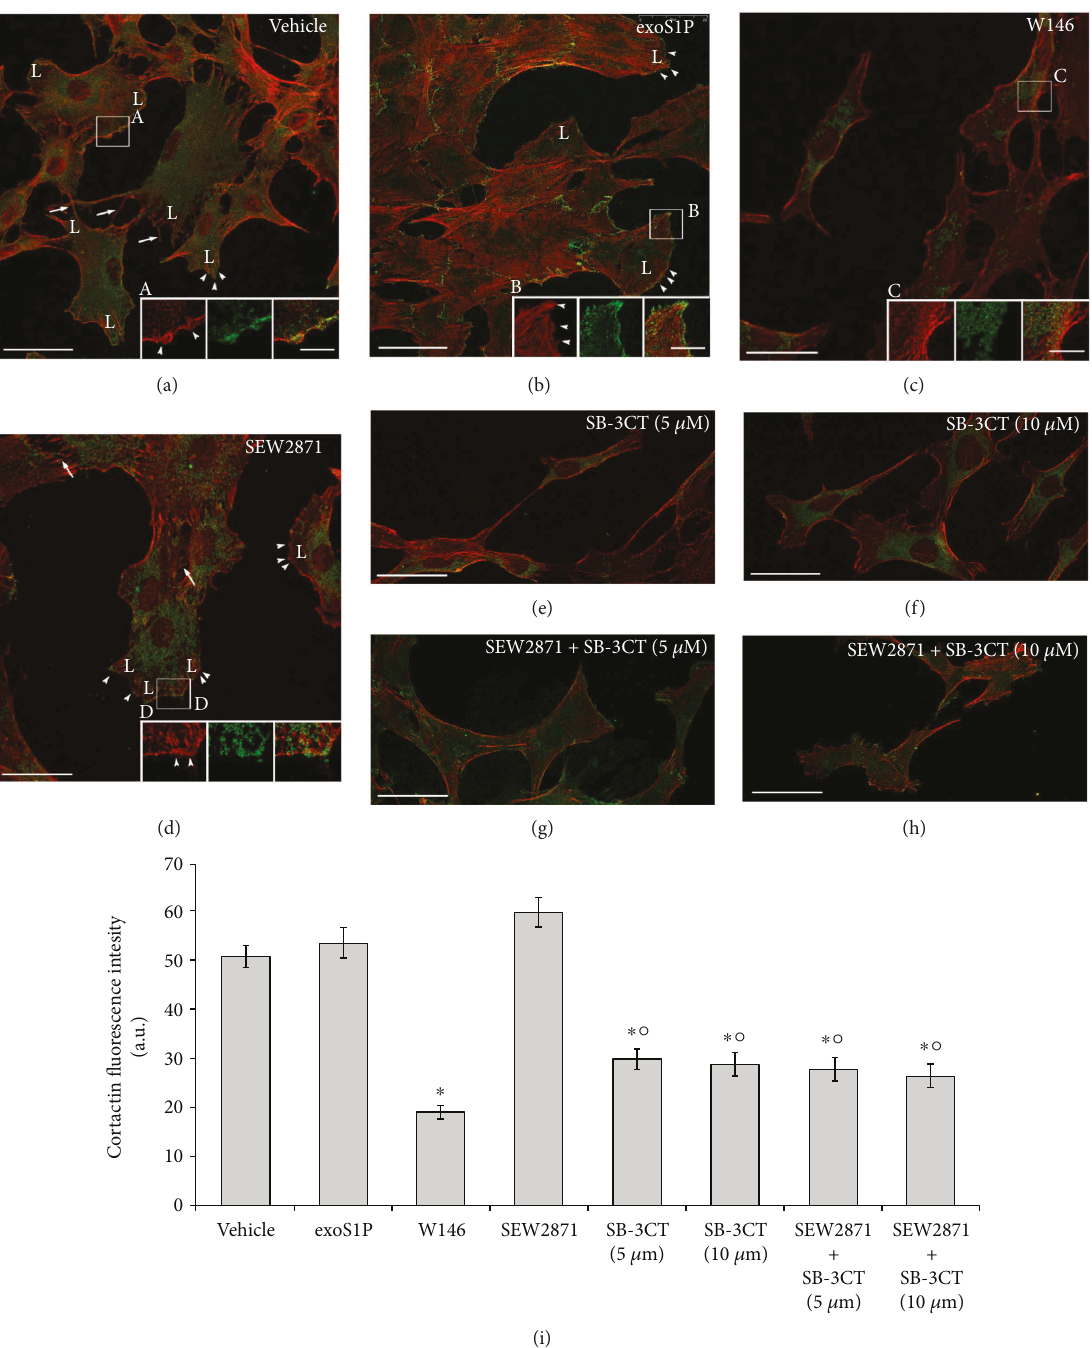
Figure 3: Cytoskeleton organization and cortactin expression. BM-MSCs were cultured for 48h in the absence (vehicle) or in presence of the following compounds: 1 μ M exogenous sphingosine-1-phosphate (exoS1P), 2 μ M S1PR1 receptor antagonist, W146, and 2 μ M S1PR1 receptor agonist, SEW2871 and/or MMP-2/9 inhibitor, SB-3CT (5 μ M or 10 μ M). (a – h) Representative immuno fl uorescence confocal images of cells cultured on glass coverslips in the indicated experimental conditions, fi xed and stained with Alexa 568-phalloidin to visualize actin fi laments (red) and immunostained with antibodies against cortactin (green). Scale bar 50 μ m. Arrows indicate fi lopodia and arrowheads indicate lamellipodia (L). (A – D) Magni fi cations of the indicated squared regions of interest showing the red and green fl uorescence signals separately and together. Yellow-orange colour indicates colocalization between the two fl uorescence signals. Scale bar 12 μ m. The images are representative of at least three independent experiments with similar results. (i) Densitometric analysis of the intensity of the cortactin fl uorescence signal performed on digitized images. Data are mean ± S.E.M. Signi fi cance of di ff erences (one-way ANOVA and Newman-Keuls multiple comparison test): ∗ p < 0 05 versus vehicle, ° p < 0 05 versus